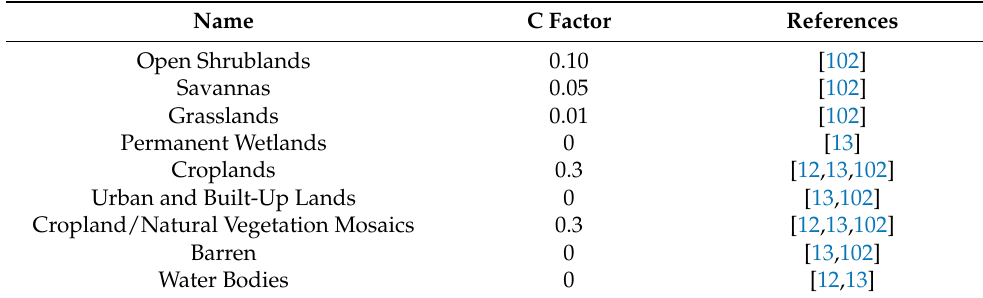
Table 6. C factors weights for different land-cover classes in the DLB (Model 2).